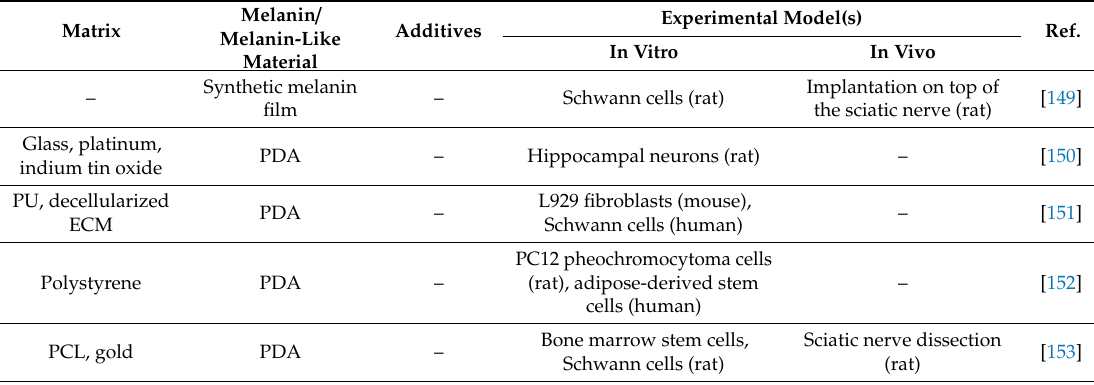
Table 4. Summary of melanin-doped materials for neural tissue